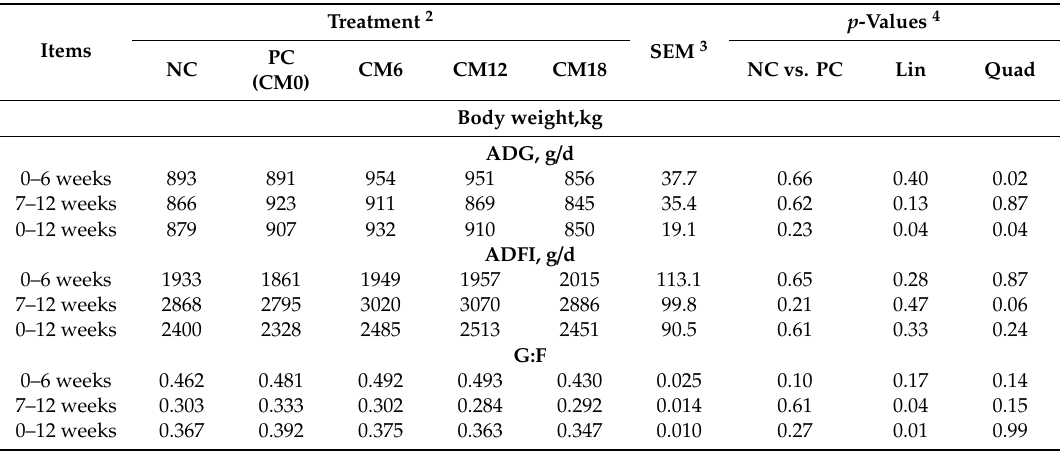
Table 5. E ff ects of copra meal (CM) inclusion level in the diet with β -mannanase on growth performance of growing-finishing pigs 1 .